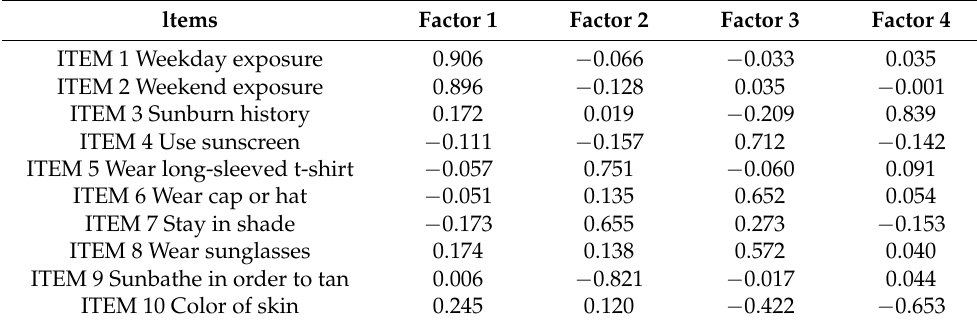
Table 4. Correlations between questionnaire items and